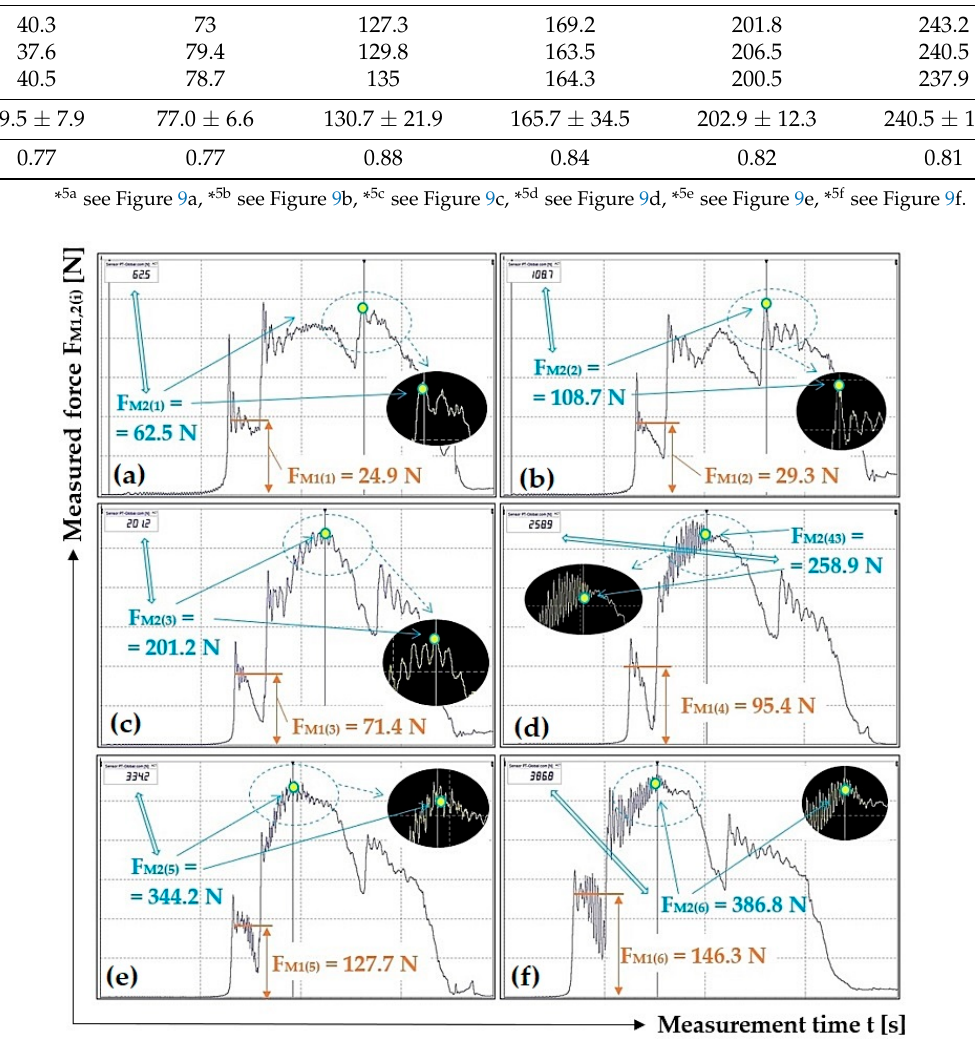
Table 6. Measured force F M1(i) [N] and F M2(i) [N] for the weight of the load G b(i) [N] at angle β = 40 deg.